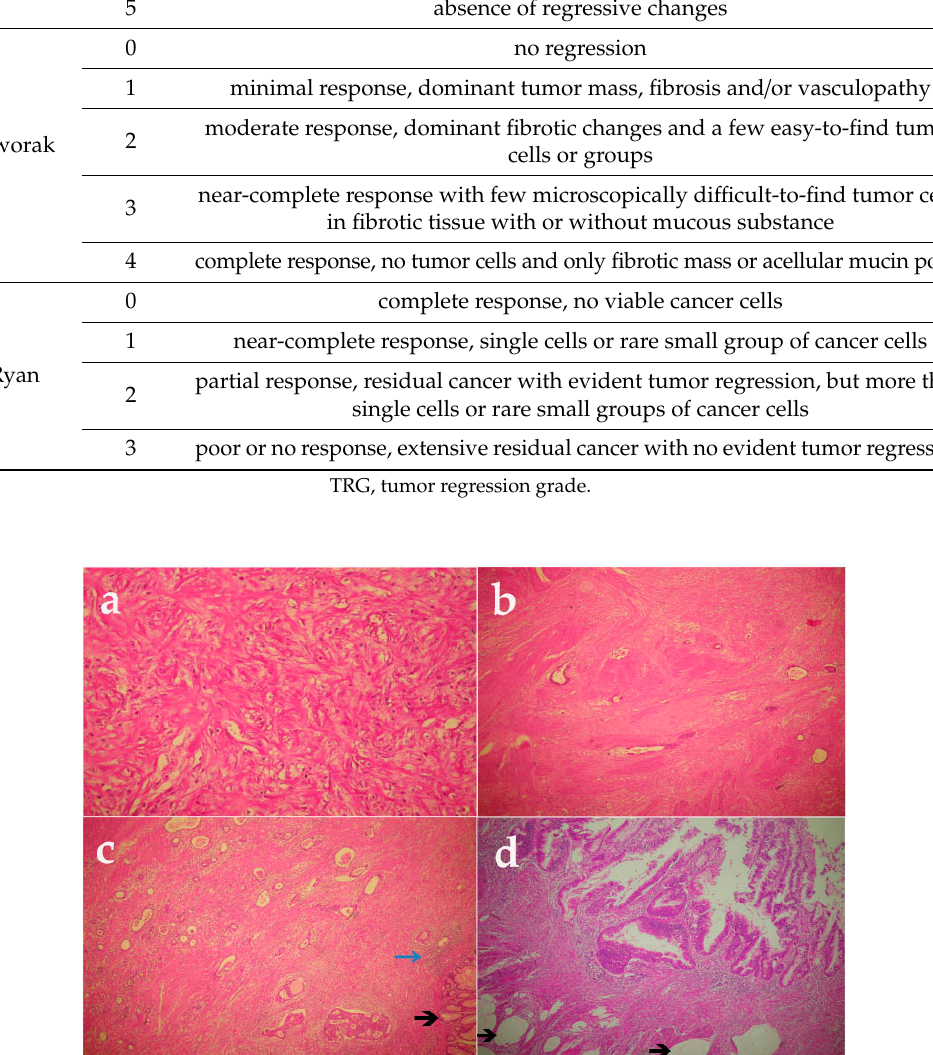
Figure 1. Representative histological appearance of modified Ryan TRG scale. ( a ) Complete tumor regression (TRG 0) (20×); ( b ) Near-complete response (TRG 1) (10×); ( c ) Partial response (TRG 2). Areas of fibrosis and focal flogosis (blue arrow), and neoplastic glands (black arrow) (10×) are shown; ( d ) Poor o no response (TRG 3). Black arrows indicate acellular mucin pools in the context of neoadjuvant therapy (20×). ( a – d ) Hematoxylin and eosin staining sections. TRG, tumor regression